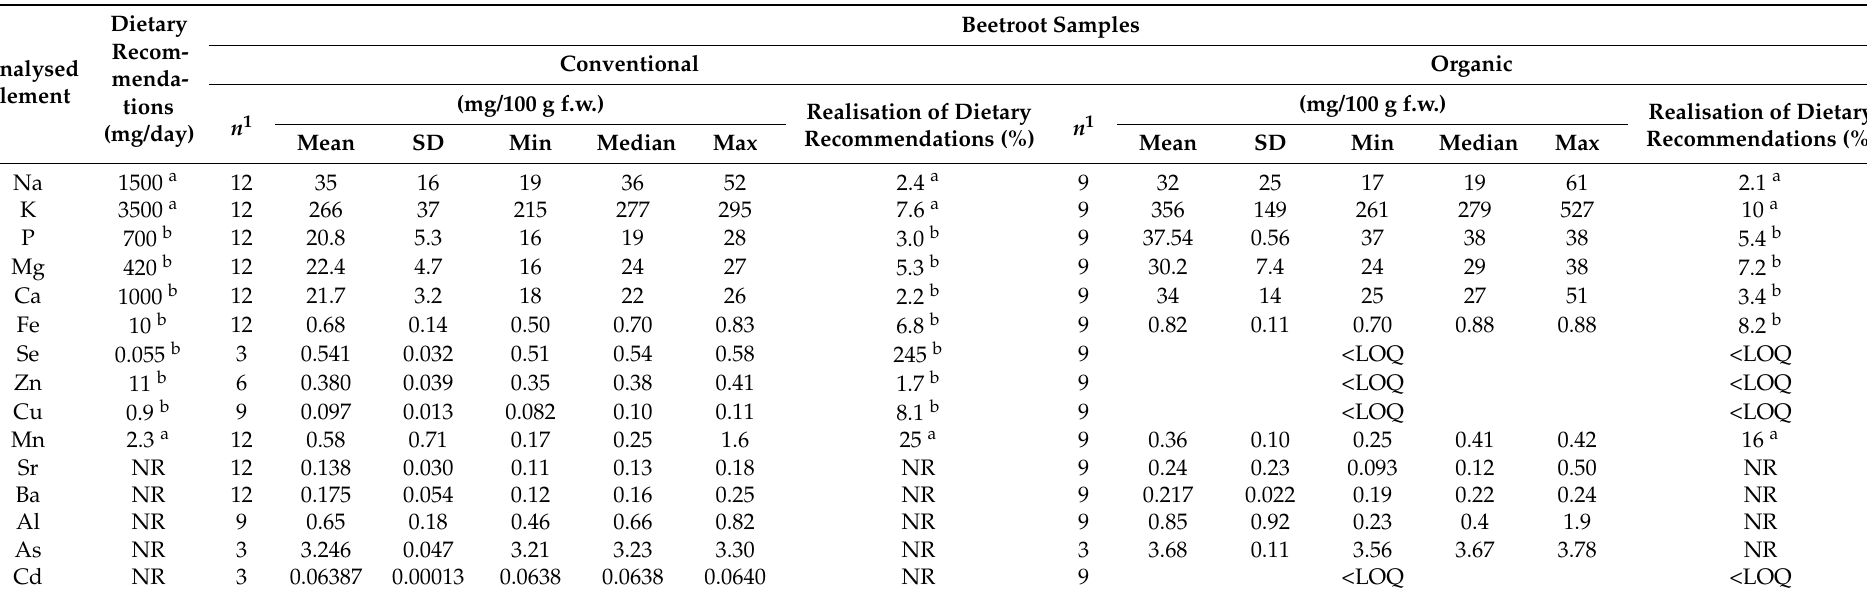
SD—standard deviation, Min—minimum, Max—maximum, n 1 —number of samples with the determined content of analysed element above LOQ (LOQ Se = 0.30 µ g/g, LOQ Zn